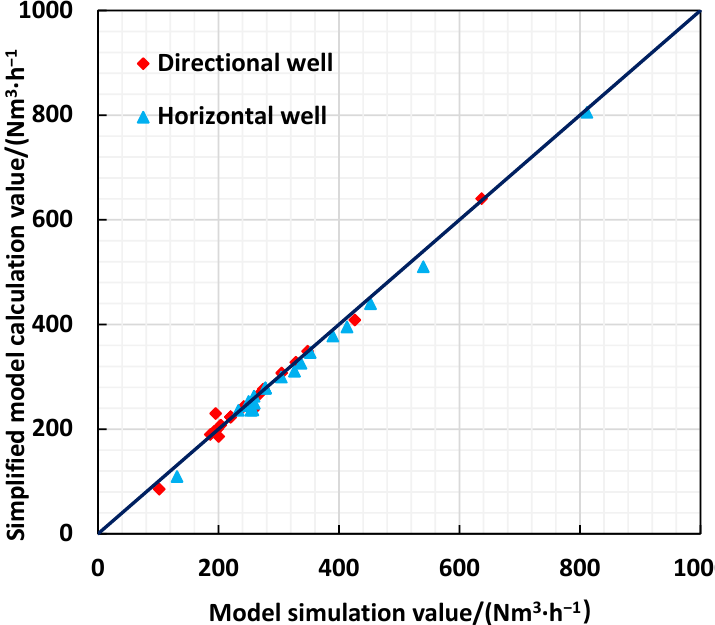
Table 3. Basic data for on-site implementation of nitrogen insulation .